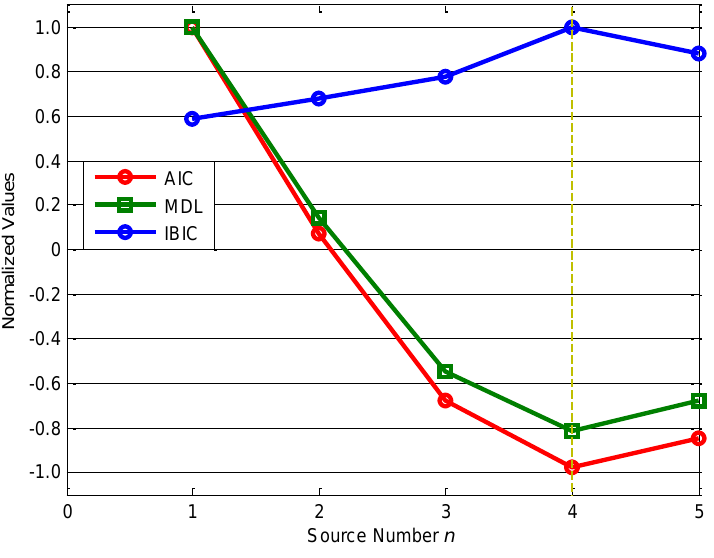
Figure 13. Source number estimation by information-based methods.